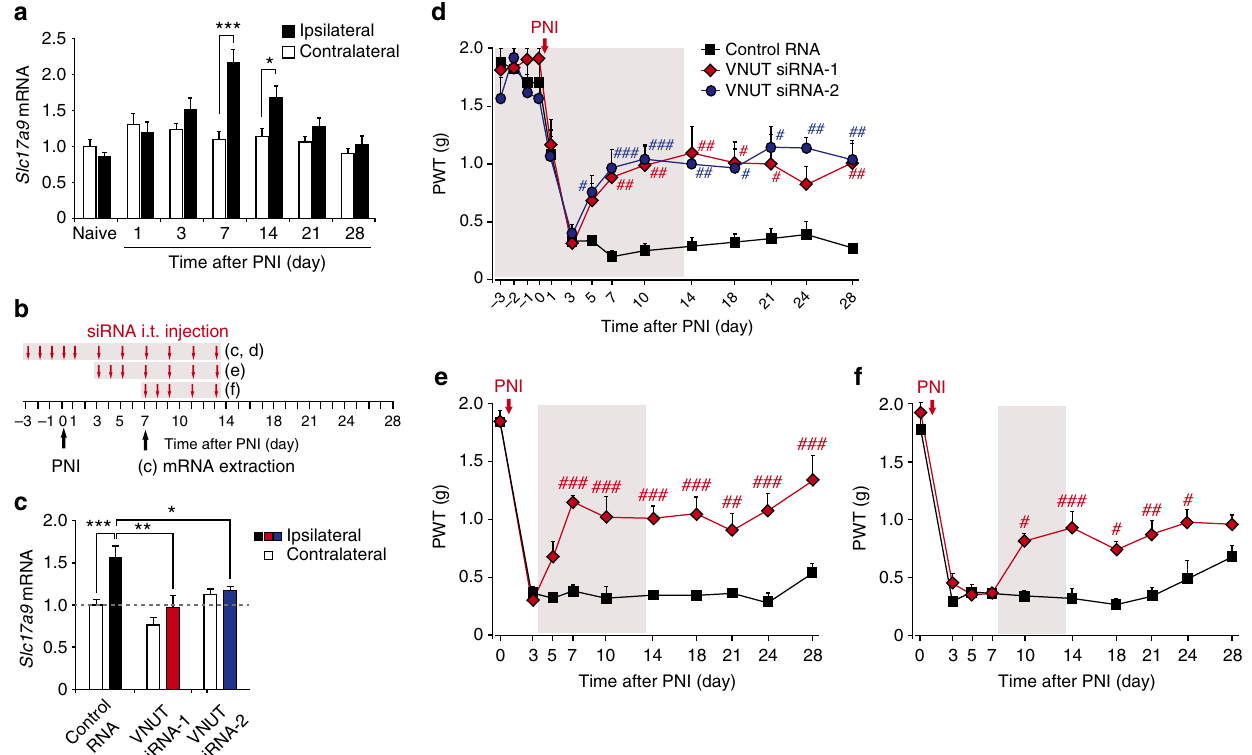
Figure 3 | PNI-induced upregulation of VNUT in the spinal cord is required for the development of tactile allodynia. ( a ) Real-time PCR analysis of Slc17a9 mRNA in total RNA extracted from spinal cord ipsilateral and contralateral to PNI before (naive) and after PNI. Values represent the relative ratio of Slc17a9 mRNA (normalized to the value for 18S mRNA) to the contralateral side of naive mice ( n ¼ 6; * P o 0.05, *** P o 0.001, two-way ANOVA with post hoc Bonferroni test). ( b ) Experimental schedule. ( c ) Real-time PCR analysis of Slc17a9 mRNA in the spinal cords of mice treated with control or VNUT siRNAs (20pmol per injection) 7 days after PNI. Values represent the relative ratio of Slc17a9 mRNA (normalized to the value for 18S mRNA) to the contralateral side of mice with control RNA (control RNA: n ¼ 8, VNUTsiRNA-1: n ¼ 5, VNUTsiRNA-2: n ¼ 5; * P o 0.05, ** P o 0.01, *** P o 0.001, one-way ANOVA with post hoc Tukey Multiple Comparison test). ( d – f ) Reversal of PNI-induced tactile allodynia by intrathecal administration of VNUT siRNA (20pmol per injection) in the ipsilateral side of WTmice ( d , control RNA: n ¼ 5, VNUTsiRNA-1: n ¼ 4, VNUTsiRNA-2: n ¼ 5; e , n ¼ 5 per group; f , control RNA: n ¼ 4, VNUT siRNA-1: n ¼ 5; # P o 0.05, ## P o 0.01, ### P o 0.001 versus control RNA, two-way ANOVA with post hoc Bonferroni test). Values are means ±